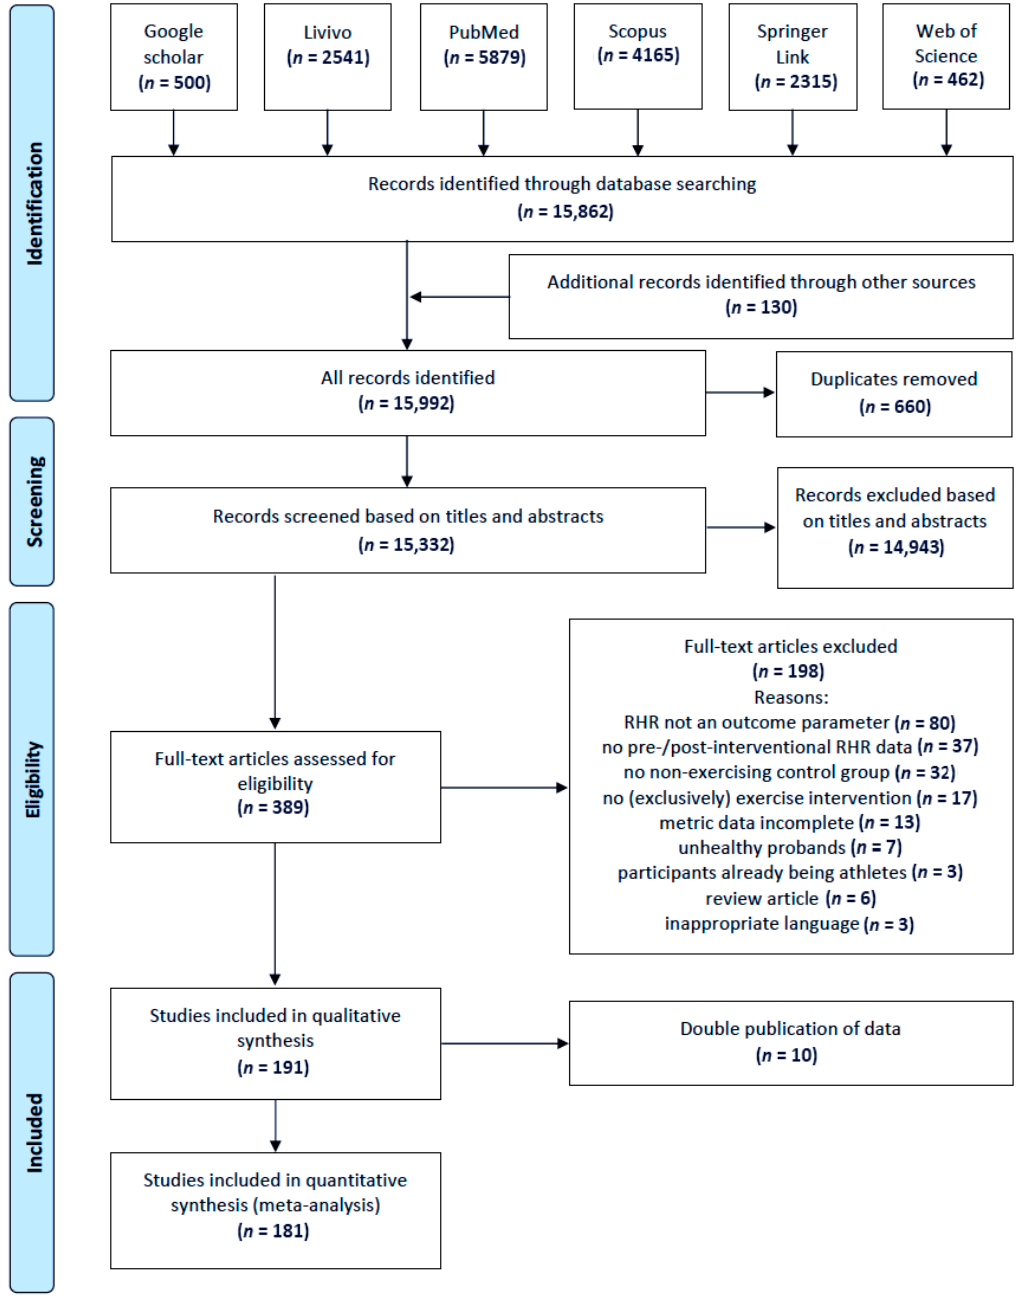
Figure 1. Flow chart of the screening and selection process for the identification of studies for inclusion in the present systematic review according to PRISMA (Moher et al. [14] ).